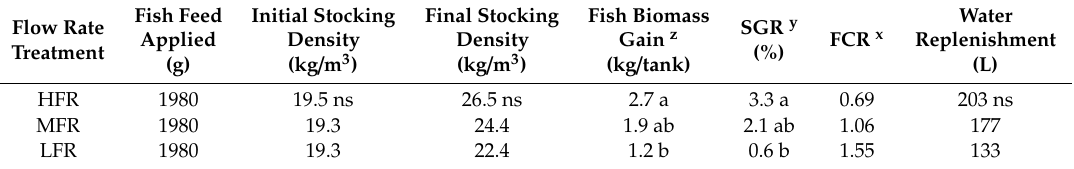
Table 6. Fish production in aquaponics grown for 4 weeks at high (HFR, 3.3 m / day),